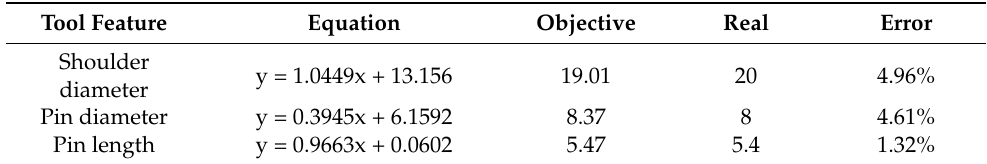
Table 5. Comparison between tool design guidelines and experimental work by other authors for series 2XXX.